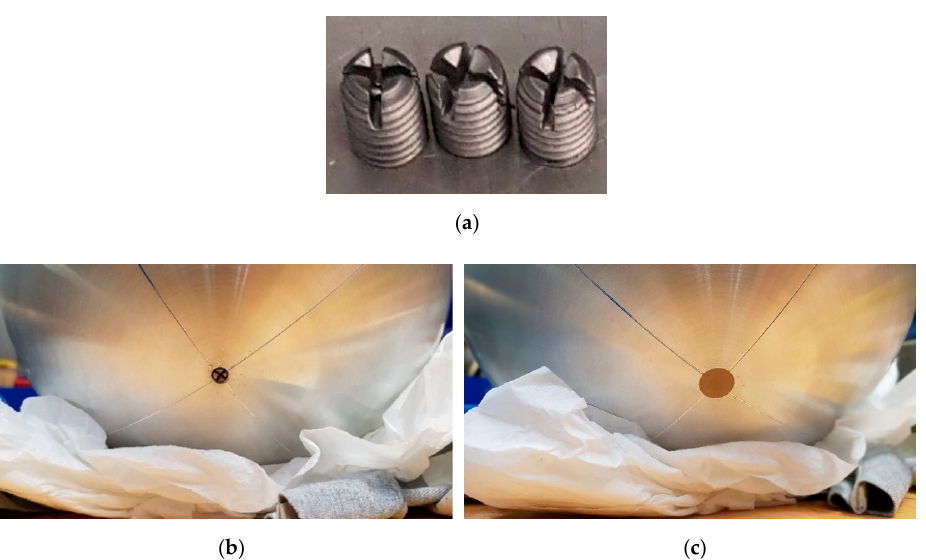
Figure 6. Custom-made nuts ( a ) mounted at the bottom hemisphere ( b ) with a cover of PVC tape ( c ). An optical 3D motion capture system was utilized to track four reflective markers installed on top of the model. In order to minimize the reflections from the model itself, the upper hemisphere shell was painted matte black. Ballast weights were CNC machined from stainless steel and mounted internally at the bottom of the lower hemisphere; see Figure 7.